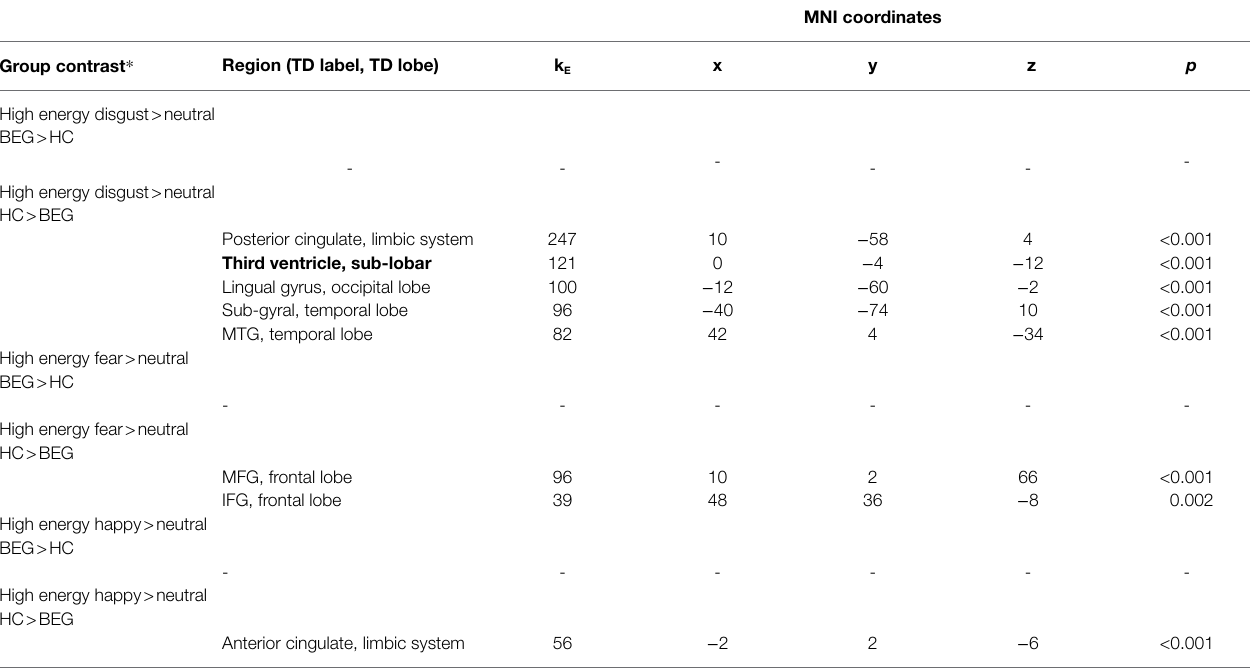
TABLE 3 | Neural activation while viewing high energy disgust, fear, and happy food images compared to neutral images, across groups.